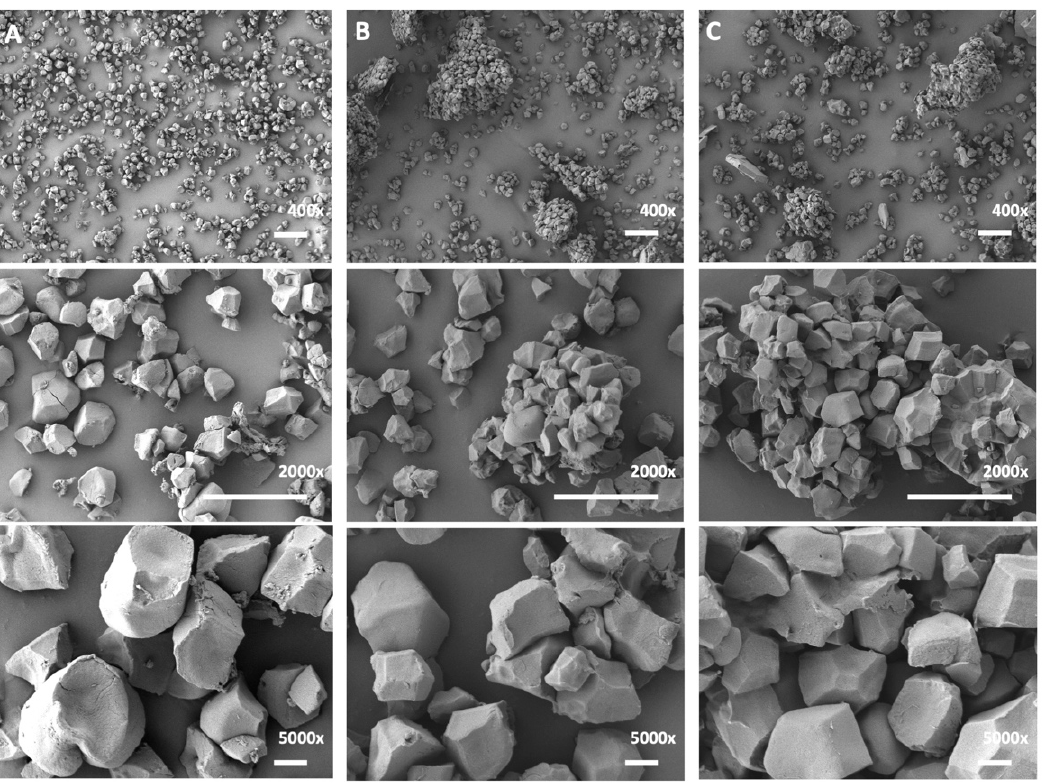
Figure 2. Images of rice starch granules prepared by scanning electron microscope (SEM) images. ( A ) Dispersion-prepared granules. ( B ) Microsieve-prepared starch granules. ( C ) Flotation-prepared starch granules. 400× magnification, bar = 10 μ m; 2000× magnification, bar = 10 μ m; 5000× magnifi- cation, bar = 1 μ m.